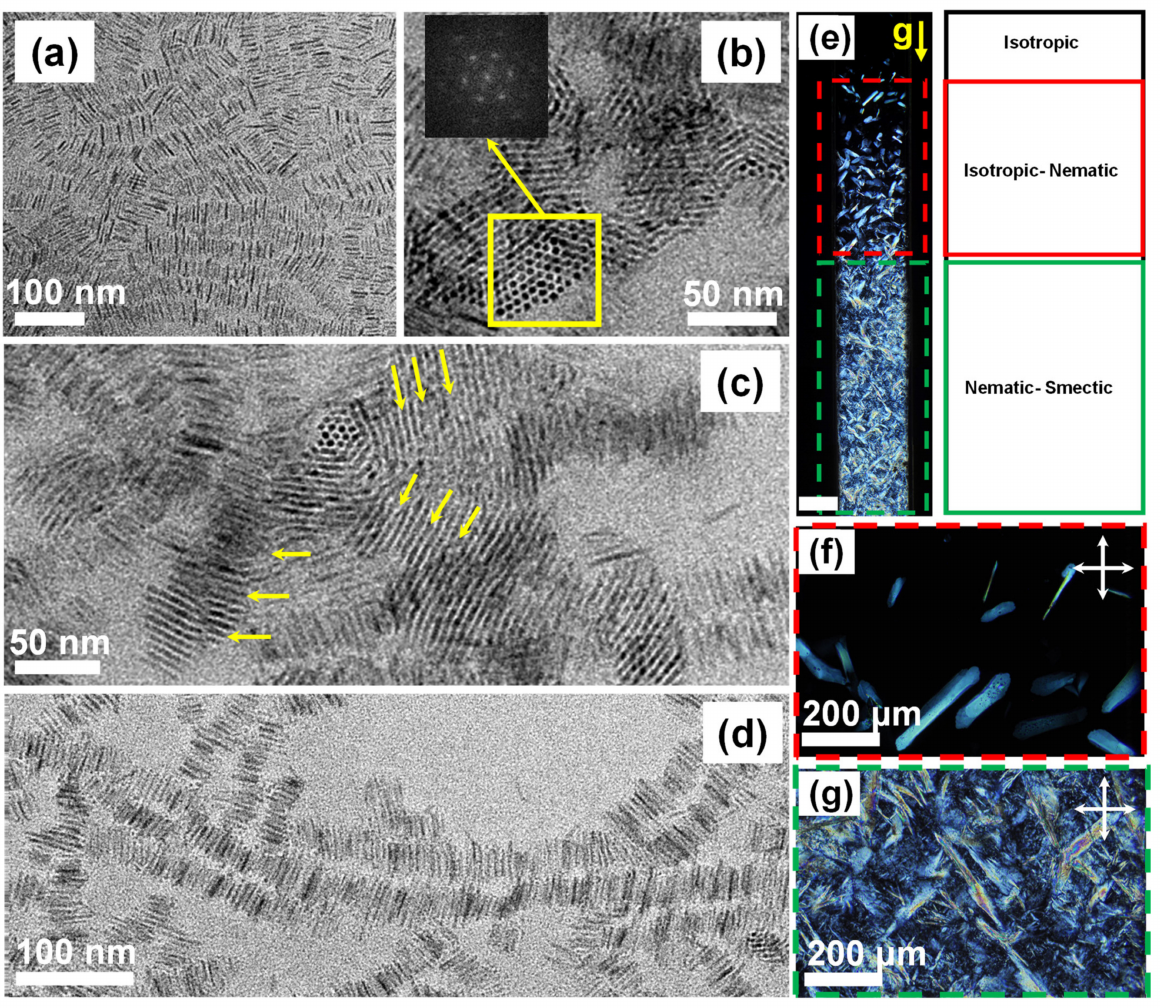
Figure 5. TEM micrographs of anatase NRs self-assembled on a TEM grid ( a – d ) and optical micro- graphs of a dispersion in toluene between crossed polarizers ( e – g ). ( a ) Anatase NRs in small smectic liquid crystal-like domains. ( b , c ) Hexagonal superlattices of vertically aligned anatase NRs. Inset in ( b ) shows the corresponding FFT pattern illustrating a close-packed hexagonal order. In ( c ), NRs have a tilted orientation, similar to rows of fallen dominoes (yellow arrows) around a vortex structure centered on a small cluster of locally homeotropically oriented NRs. In ( d ), a linear “rail-track” pattern was observed from the side-by-side assembly of the NRs into the rail-tracks of various lengths. ( e ) A sedimenting sample from a dispersion of anatase NRs in toluene (~29 vol%) in a capillary with three distinct regions. From top to bottom: isotropic fluid at the top, ( f ) elongated nematic tactoids floating in the isotropic fluid, and ( g ) coexistence of nematic domains and sharped-edge smectic LC phases. Scale bar in ( e ) is 500 µ